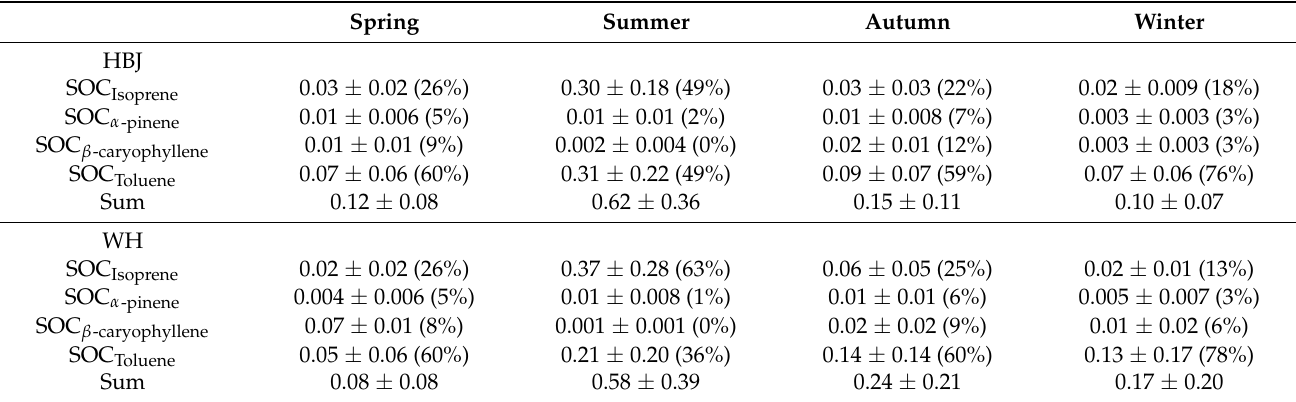
Table 4. Seasonal concentration ( µ g m − 3 ) and contribution (%) of SOC estimated by the tracer yield method in Bengbu. Spring Summer Autumn Winter HBJ SOC